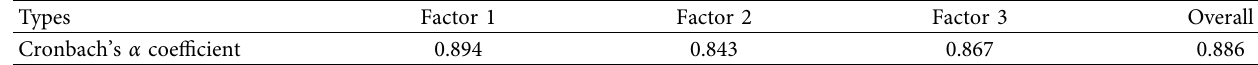
Table 2: Consistent reliability test